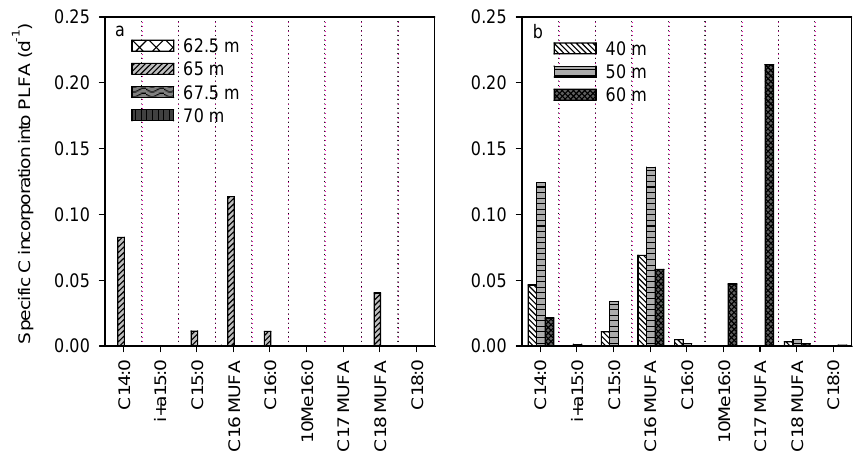
Figure 5. Specific CH 4 -derived C incorporation pattern into phospholipid fatty acids (PLFAs; incorporation rates of C into PLFAs normalized on PLFA concentration, d − 1 ) in (a) September 2012 (dry season) in the southern basin and (b) in February 2012 (rainy season) in the northern basin. Dissolved O 2 concentration was lower than 3µmolL − 1 at 67.5 and 70m (a) , and 50 and 60m (b) .